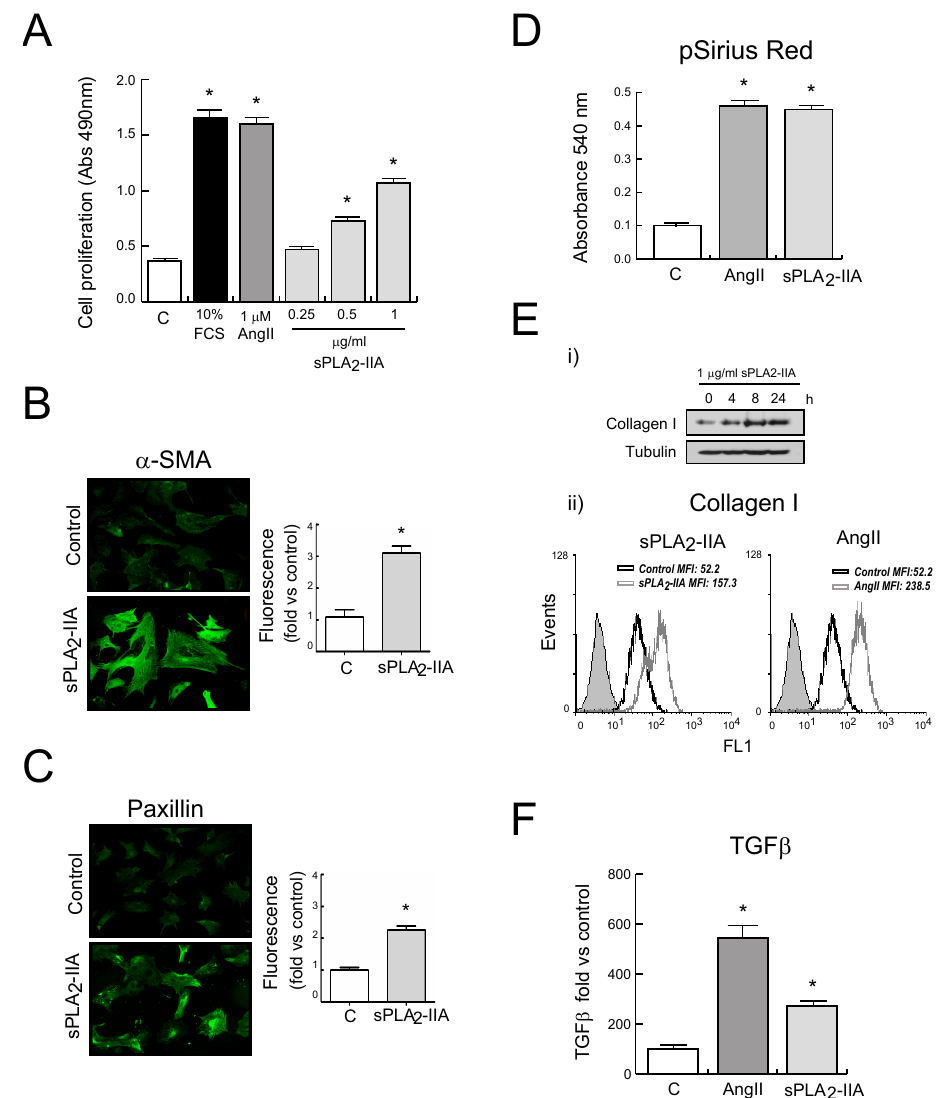
Figure 2. sPLA 2 -IIA modulates cardiac fibroblast (CFs) phenotype. Rat CFs were treated with the indicated stimuli. ( A ) After 24 h of incubation, cell proliferation was investigated and expressed as mean ± SD. After 24 h of incubation, α SMA ( B ) and paxillin ( C ) expression were examined by fluorescence microscopy. Representative images of resting and sPLA 2 -IIA-stimulated cells (objective lens 20 × , magnification 200 × ) and quantitative analysis. ( D ) After 72 h of incubation, total collagen accumulation was stained with picro-Sirius red and quantified by spectrophotometric analysis. ( E ) Collagen I protein expression: ( i ) Western blot of CF stimulated at the indicated times, and ( ii ) flow cytometry histograms of CF upon 24 h stimulation (untreated-CFs (open black curves) and treated-CFs (open grey curves) were compared with isotype controls (solid grey curves)). ( F ) TGFβ expression was evaluated after 24 h of stimulation by flow cytometry analysis. The graphic represents the mean fluorescence intensity (MFI) and was shown by fold control. * p < 0.001 vs. control cells, n = 3.